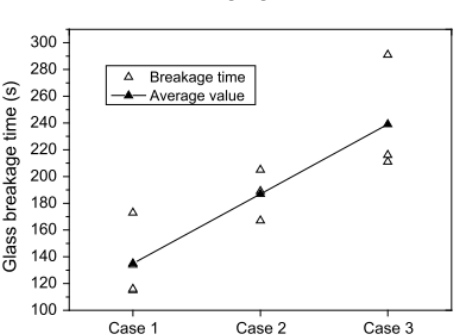
Fig. 9 Time until the first crack of case 1, case 2 and case 3 (Wang 2019).